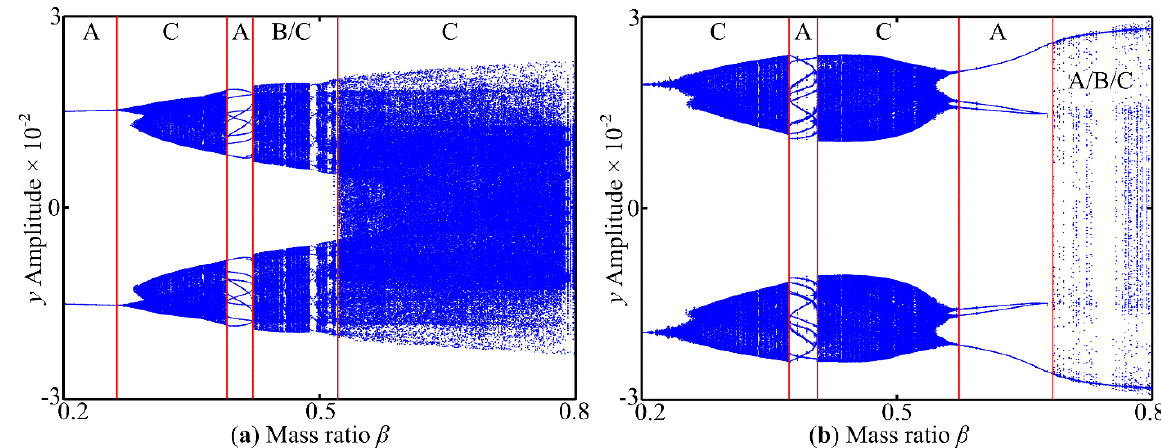
Figure 8. Bifurcation diagram of system response with β : ( a ) k a = 2.1 × 10 6 , k b = 8.6 × 10 4 ; ( b ) k a = 9.2 × 10 5 , k b = 8.6 × 10 5 (A: periodic motion; B: quasi-periodic motion; C: chaotic motion).